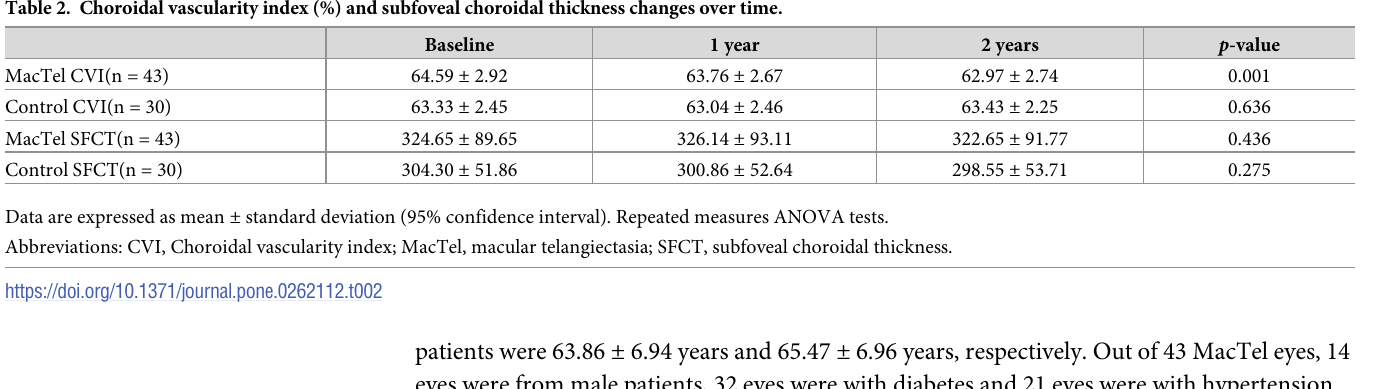
patients were 63.86 ± 6.94 years and 65.47 ± 6.96 years, respectively. Out of 43 MacTel eyes, 14 eyes were from male patients, 32 eyes were with diabetes and 21 eyes were with hypertension. The mean refractive errors were -0.10 ± 2.19 diopters and the mean BCVA were 0.17 ± 0.14 logMAR (20/30 Snellen equivalent) in the MacTel group at initial visit. The MacTel group had the mean intraocular pressure of 14.12 ± 3.58 mmHg, the mean SFCT of 324.65 ± 89.65 μ m, and the CVI of 64.59 ± 2.92%. These baseline measurements from the MacTel group were not significantly different from the baseline measurements from the control group, except for BCVA. The CVI and SFCT changes of each group were observed on a yearly basis, which is sum- marized in Table 2. The mean CVI of MacTel group were 64.59 ± 2.92%, 63.76 ± 2.67%, and 62.97 ± 2.74% at baseline, 1 and 2 years, respectively. In this group, the repeated measures ANOVA test showed p < 0.001, and the p value of post hoc analysis for baseline versus 1 year was 0.005, for 1 year versus 2 years was 0.019, and for baseline versus 2 years was < 0.001 (Fig 2). The mean CVI of control group were 63.33 ± 2.45%, 63.04 ± 2.46%, and 63.43 ± 2.25% at